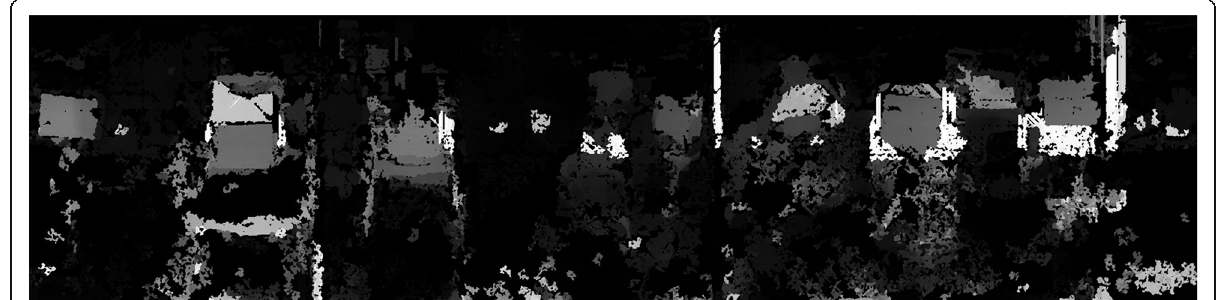
Fig. 12. The gray scale of the pixel points in the disparity